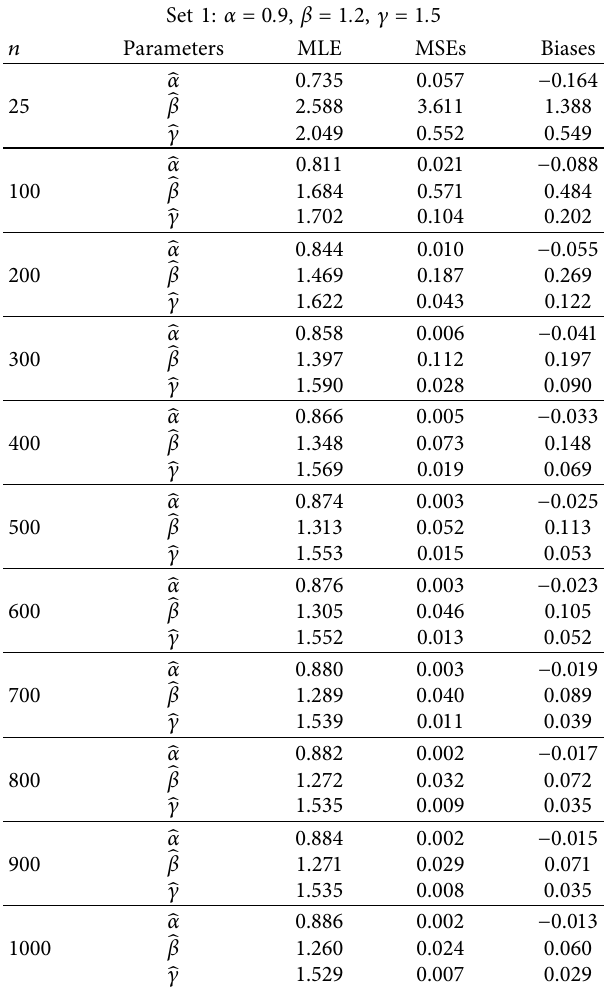
Table 1: Monte Carlo simulation results of the HTBPT–Weibull